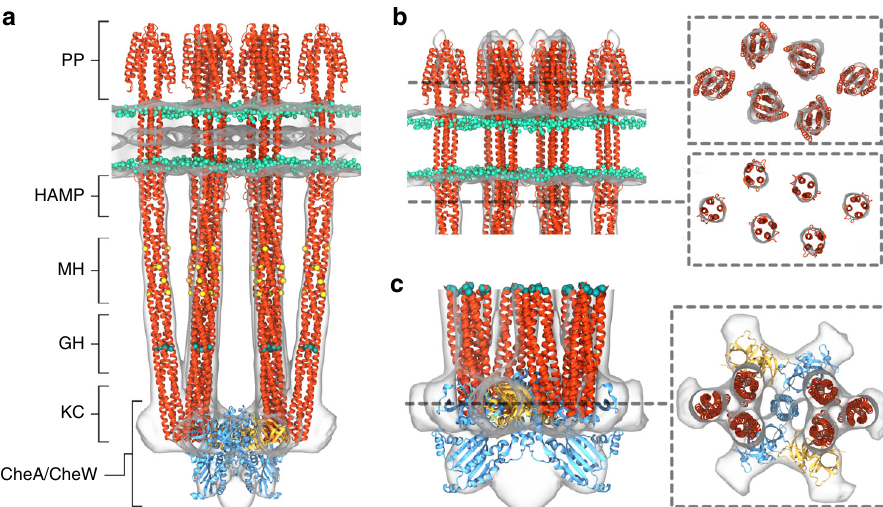
Fig. 5 Molecular model of the complete E. coli core signalling unit. a Overlay between CSU model and masked 3D density map shown with surface representation at an isovalue threshold of 0.016. Colours and labels in the model as in Fig. 4. b Zoom of membrane and membrane-proximal receptor domains from side (left) and at vertical slices taken through the periplasmic (top right) and HAMP (botton right) domains. To visualise the densities corresponding to the periplasmic domains, the map threshold is lowered to 0.0045 in the side view and the slice through the periplasmic domain. c Zoom of CheA/CheW baseplate region from side (left) and top (right). For the side view representation, the map and model have been rotated by 45° to highlight excess density between CheA.P4 domains. NB. Bulges of empty density at the level of the KC module, in both panel a and panel c , correspond to CheA or CheW molecules of neighbouring CSUs in the higher-order array structure not depicted in this visualisation. Source data are provided as a Source Data fi